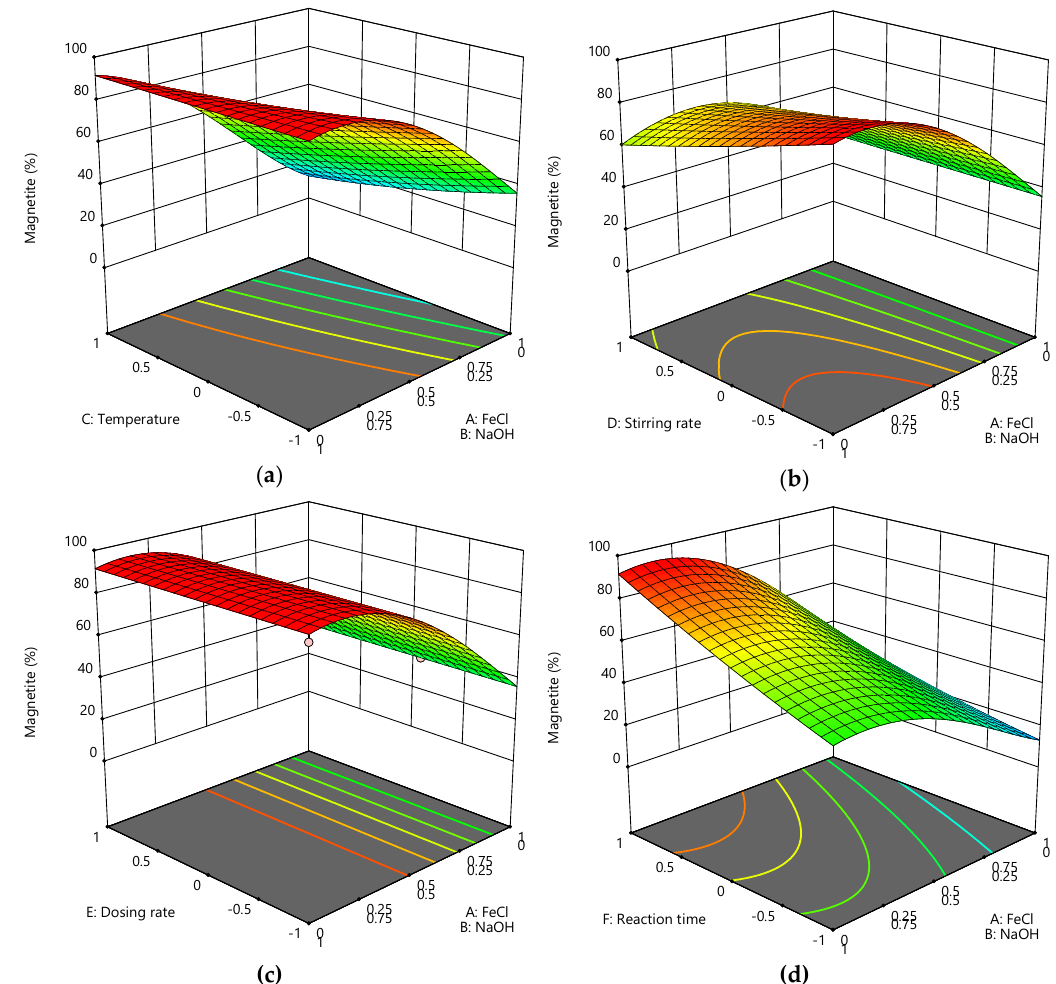
Figure 5. The predicted magnetite share in the iron oxide nanoparticles obtained from Raman spectroscopy depending on temperature and iron salt/sodium hydroxide concentration while stirring rate and reaction time is maximal and dosing rate is minimal (a) . The predicted magnetite share depending on stirring rate and iron salt/sodium hydroxide concentration while temperature and reaction time is maximal and dosing rate is minimal (b) . The predicted magnetite share depending on dosing rate and iron salt/sodium hydroxide concentration while temperature, stirring rate and reaction time is maximal (c) . The predicted magnetite share and iron salt/sodium hydroxide concentration while stirring rate and temperature is maximal and dosing rate is minimal (d) .